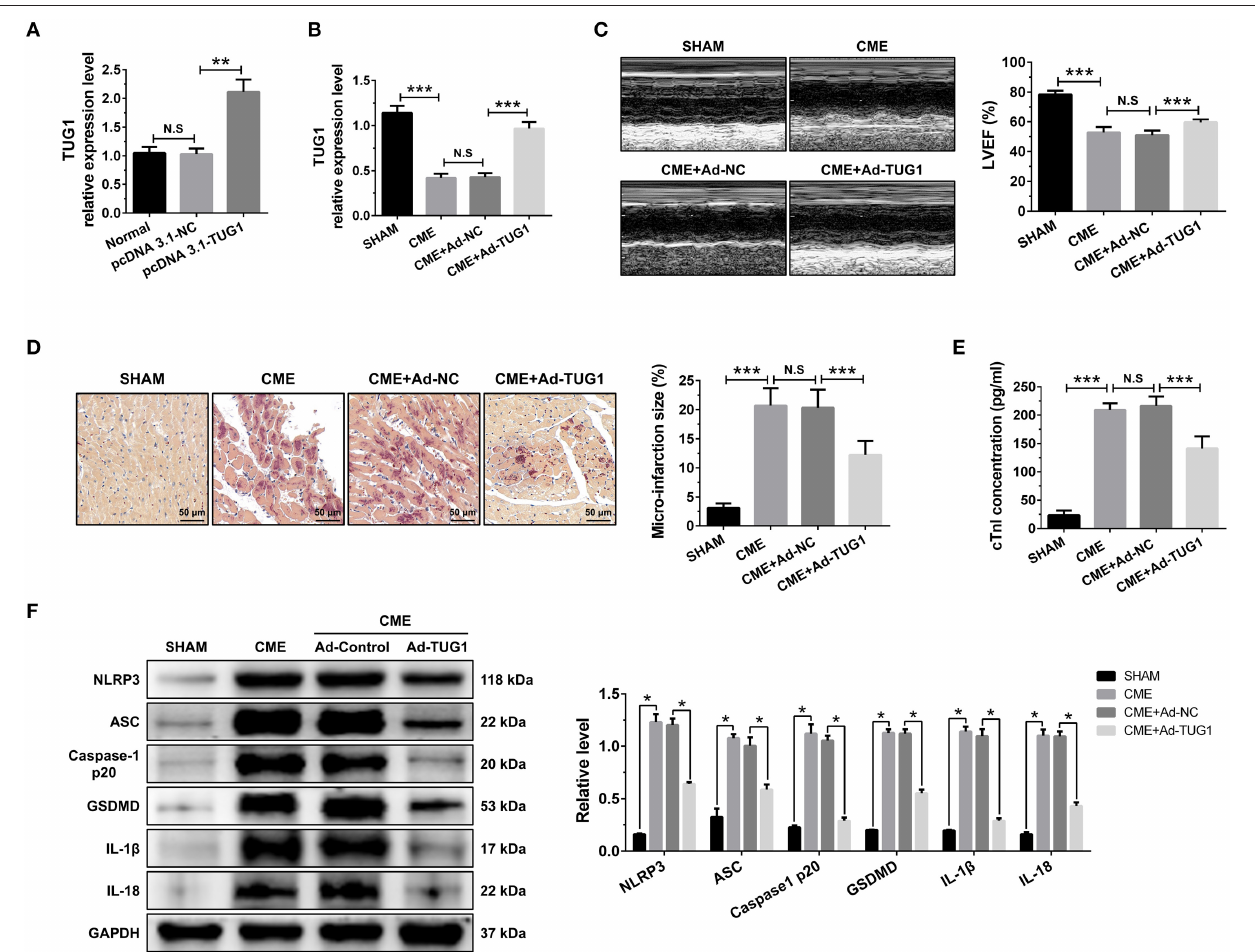
FIGURE 2 | TUG1 overexpression reduces myocardial damage and pyroptosis following CME. (A) Transfection with pcDNA3.1-TUG1 plasmids significantly increased TUG1 level in H9C2 cells ( n = 3, * P < 0.05, ** P < 0.01, *** P < 0.001). (B) Transfection with AAV-pcDNA3.1-TUG1 significantly increased myocardial TUG1 level following CME ( n = 10). (C) Echocardiography was used to assess cardiac function and to quantify LVEF ( n = 10). (D) HBFP staining was used to measure microinfarct size ( × 200; scale bar = 50 µ m) ( n = 5). (E) cTnI parameters for rats in each group ( n = 10). (F) Western blotting was used to quantify myocardial NLRP3, ASC, caspase-1 p20, GSDMD, IL-1 β , and IL-18 protein levels with GAPDH as a loading control ( n = 3). Data are mean ± SEM from three or more independent experiments. * P < 0.05, ** P < 0.01, *** P <